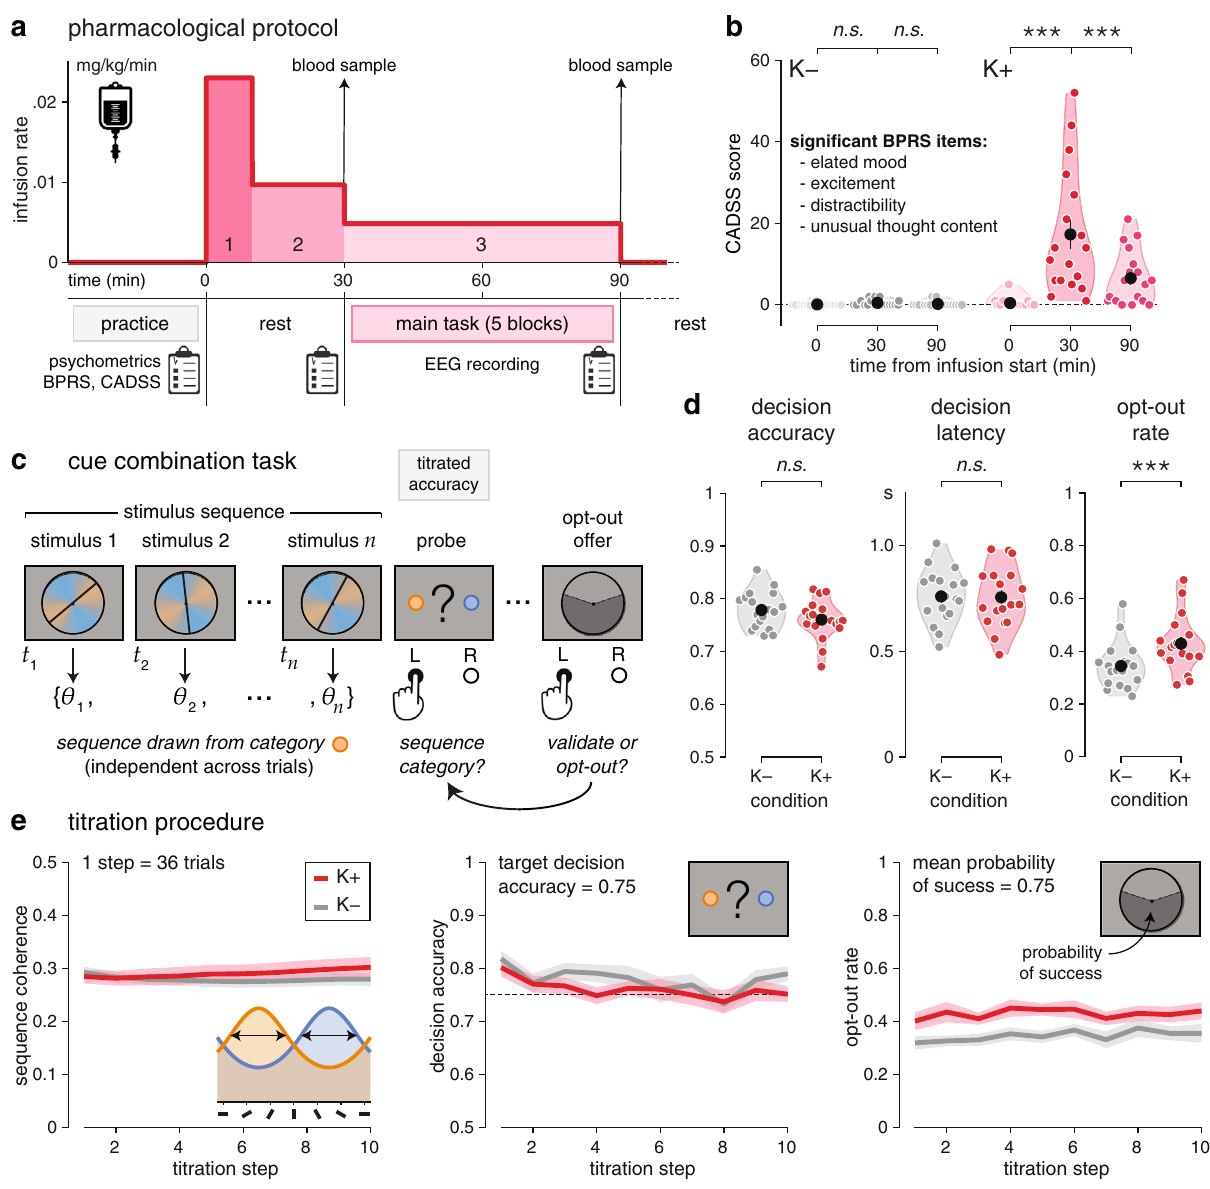
Fig. 1 Pharmacological protocol and cue combination task. a Description of the pharmacological protocol. Top: three-stage infusion protocol used to achieve constant plasma concentration of ketamine of 150 ng/mL during task execution. Bottom: task-related events. b Scores on the Clinician Administered Dissociative States Scale (CADSS). Only four items of the Brief Psychiatric Rating Scale (BPRS) show increased ratings under ketamine (K + ) than placebo (K − ). c Description of the cue combination task. Each trial consists of a sequence of 4 to 12 oriented stimuli θ average rate of 2.5 Hz, after which participants are probed for a response (left- or right-handed) regarding the category of the sequence. Accuracy is titrated online by adjusting the coherence of the stimulus sequence — corresponding to the concentration of the distributions of orientations associated with each category. At the end of each trial, participants are offered the possibility to opt out of their decision, in which case they are rewarded not based on decision accuracy, but based on a lottery of described probability of success. d Task behavior (left: decision accuracy; middle: decision latency; right: opt- out rate). Participants opt out of their decisions more often under ketamine than placebo. e Titration procedure targeting a decision accuracy of 0.75. Left: temporal evolution of sequence coherence across titration steps (1 step = 36 trials). Middle: temporal evolution of decision accuracy across titration steps. Right: temporal evolution of opt-out rate across titration steps. Black dots and error bars indicate group-level means ± s.e.m., whereas colored dots indicate participant-level data. Three stars indicate a signi fi cant effect at p < 0.001, n.s. a non-signi fi cant effect ( N = 18 participants, uncorrected two-sided t tests). Source data are provided as a Source Data fi le.